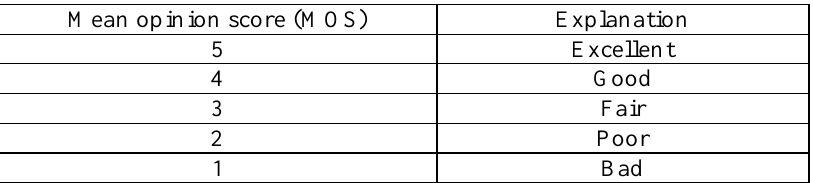
Scale for Quality of Experience Rating and